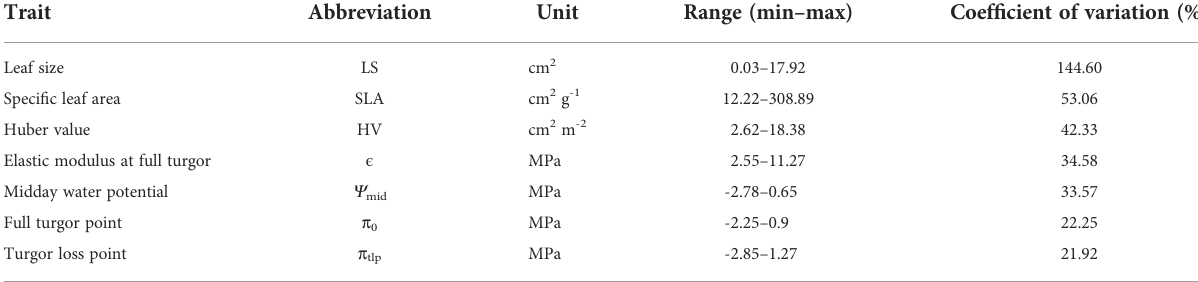
TABLE 1 Summary of the seven leaf drought tolerance traits of the 37 shrub species included in this